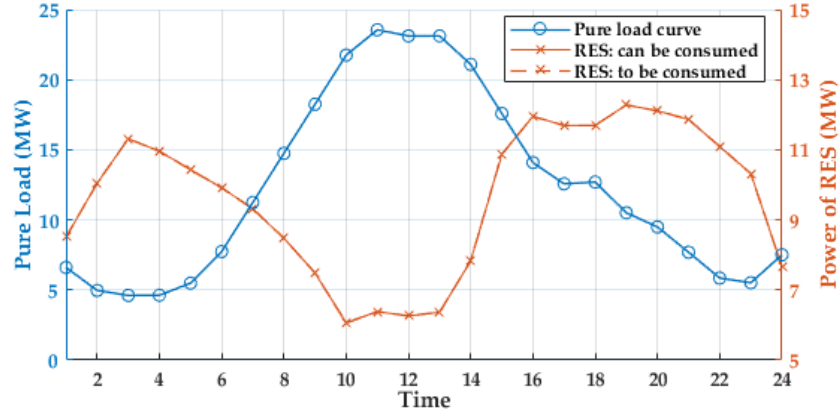
Figure 6. Conventional generation curve and RES curve through the proposed DR scheme to get balance.